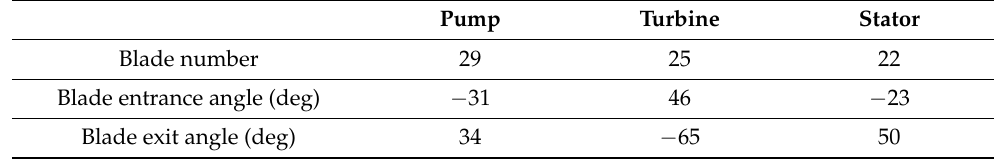
Table 2. Torque converter cascade parameters.